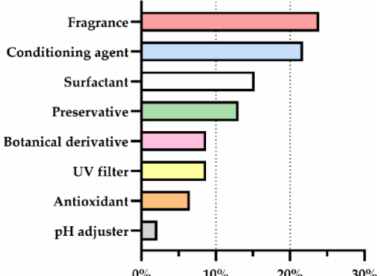
Figure 5. Function of allergens other than fragrances present in the analyzed cosmetic products for sensitive skin, in percentage. (UV =